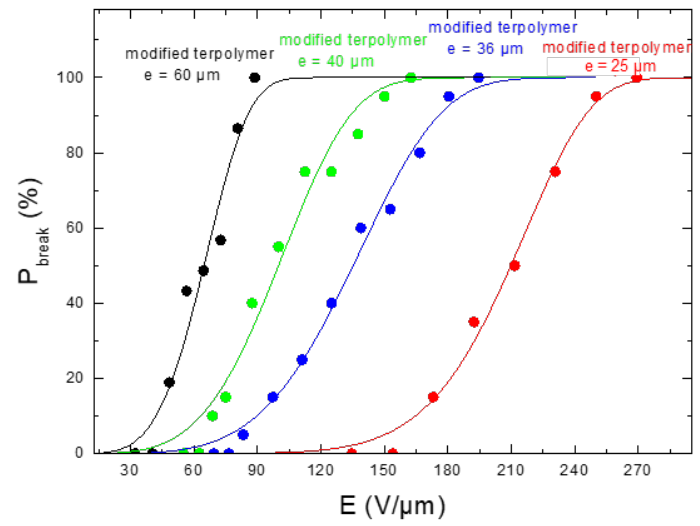
Figure 6. Breakdown probability versus electric field of modified terpolymers with different thicknesses.